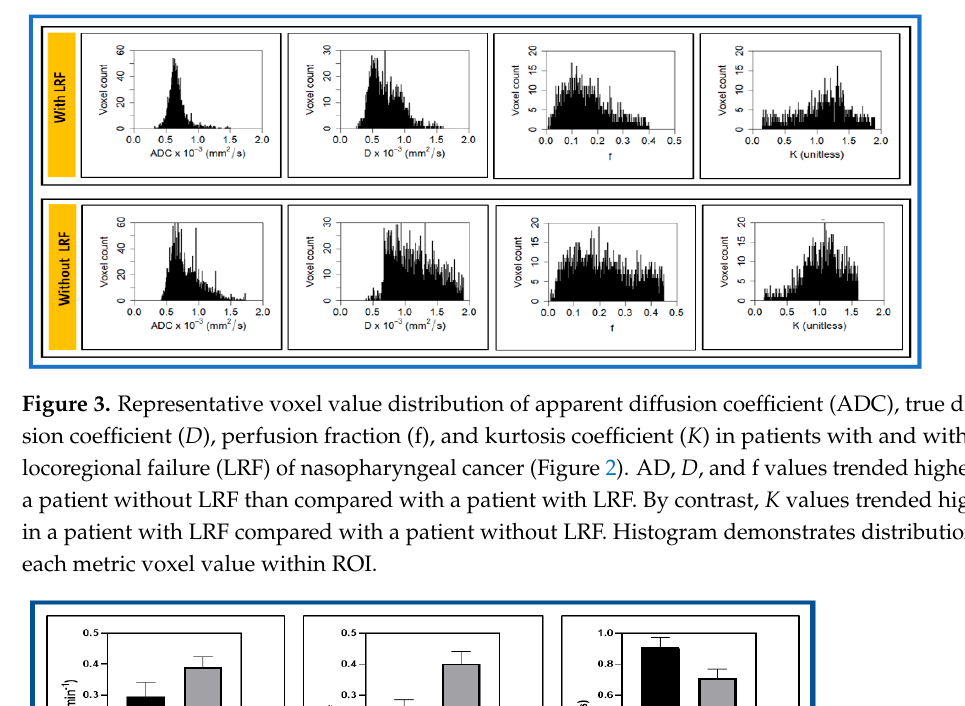
Figure 3. Representative voxel value distribution of apparent diffusion coefficient (ADC), true dif- fusion coefficient ( D ), perfusion fraction (f), and kurtosis coefficient ( K ) in patients with and without locoregional failure (LRF) of nasopharyngeal cancer (Figure 2). AD, D , and f values trended higher in a patient without LRF than compared with a patient with LRF. By contrast, K values trended higher in a patient with LRF compared with a patient without LRF. Histogram demonstrates distri- bution of each metric voxel value within ROI.